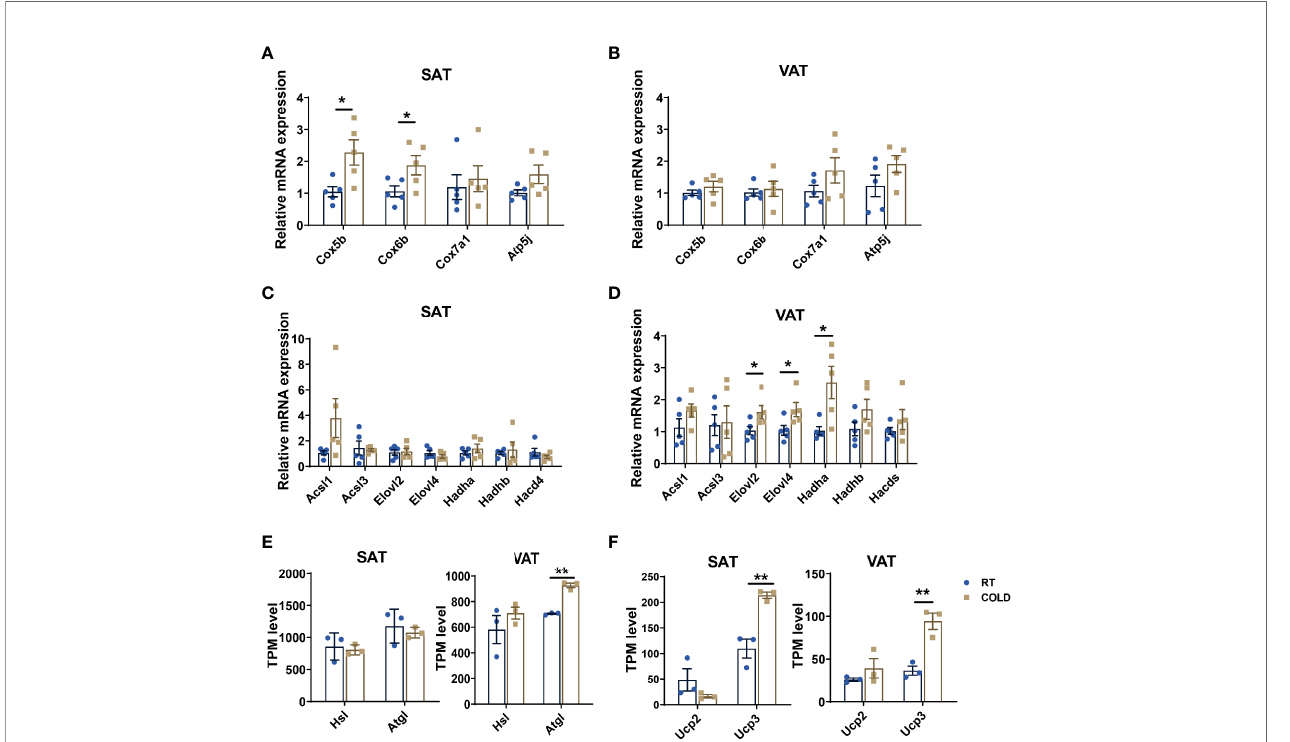
FIGURE 5 | Cold exposure induced alterations in heat production processes. (A – D) qPCR validation of the expression of genes related to thermogenesis and fatty acid metabolism in SAT and VAT from RT and cold-treated pigs (n = 5). (E, F) Transcripts per million (TPM) expression values of lipolysis markers ( ATGL , HSL ) and cold-induced genes ( UCP2 , UCP3 ) of SAT and VAT from cold-treated and RT pigs were shown to estimate relative gene expression abundance (n = 3). Error bars represent SEM. * P < 0.05, ** P < 0.01, two-tailed Student ’ s